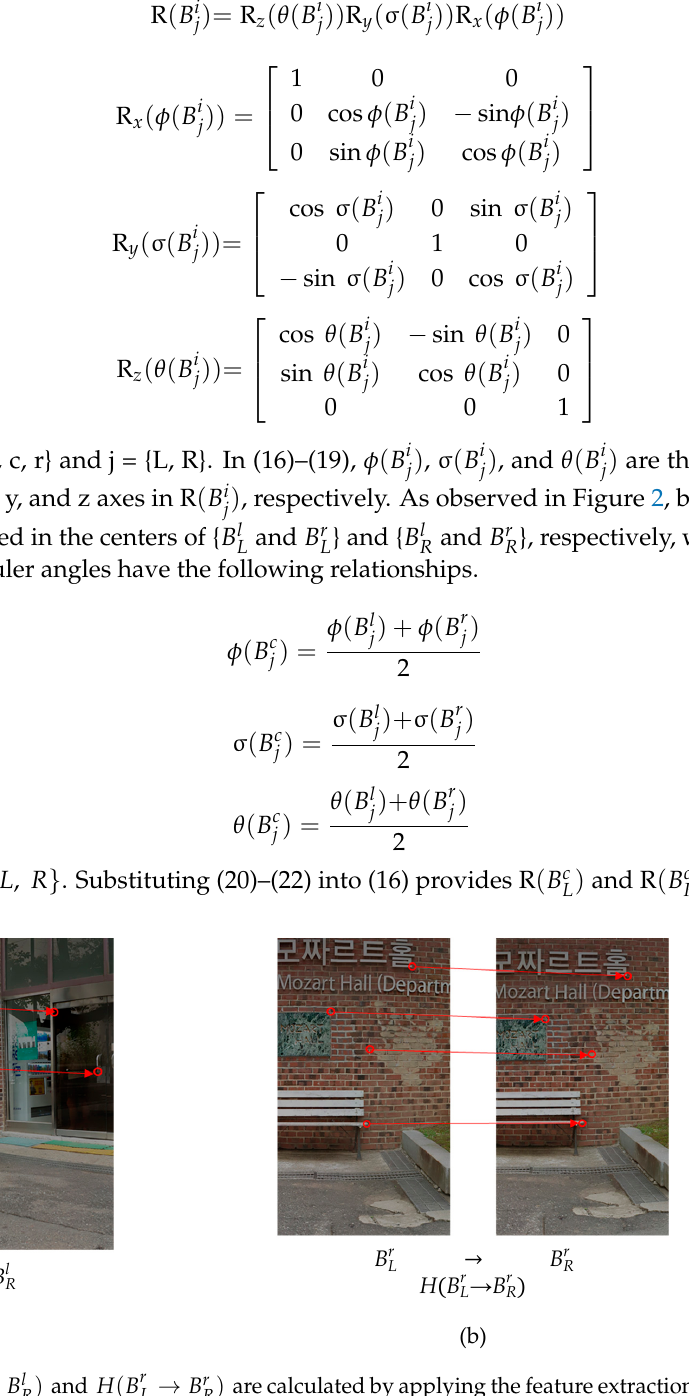
→ B l ) ; ( b ) Example L R